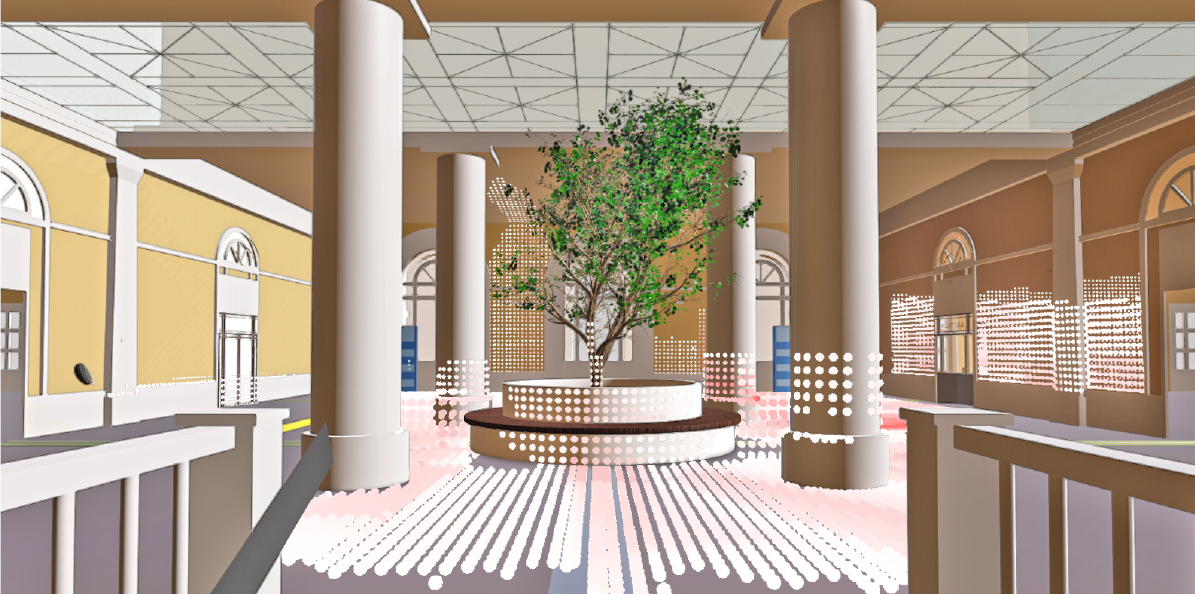
Figure 1. Heat map produced by the